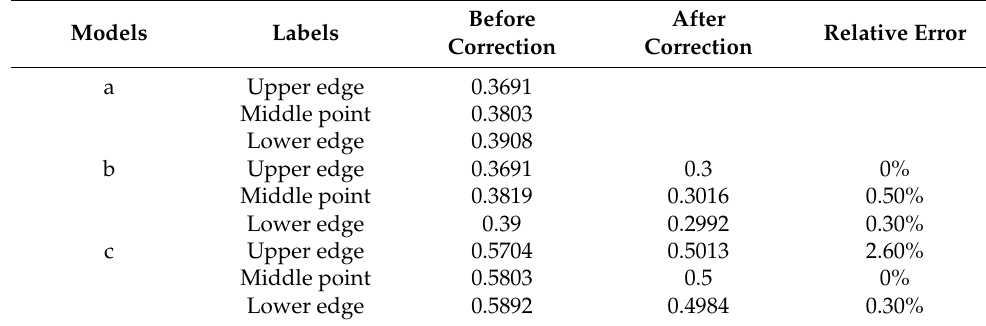
Figure 11. Three different labeling methods. Table 1. Inversion results of depth of homogeneous medium model.